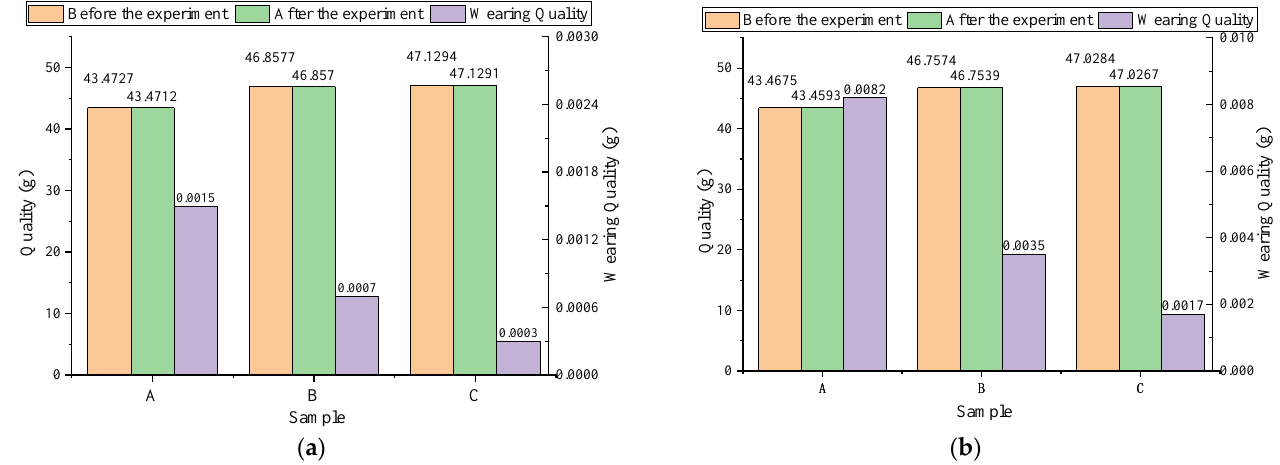
Figure 9. Abrasion of different test conditions. ( a ) A load of 20 N, and a time of 10 min; ( b ) A load of 100 N and a time of 30